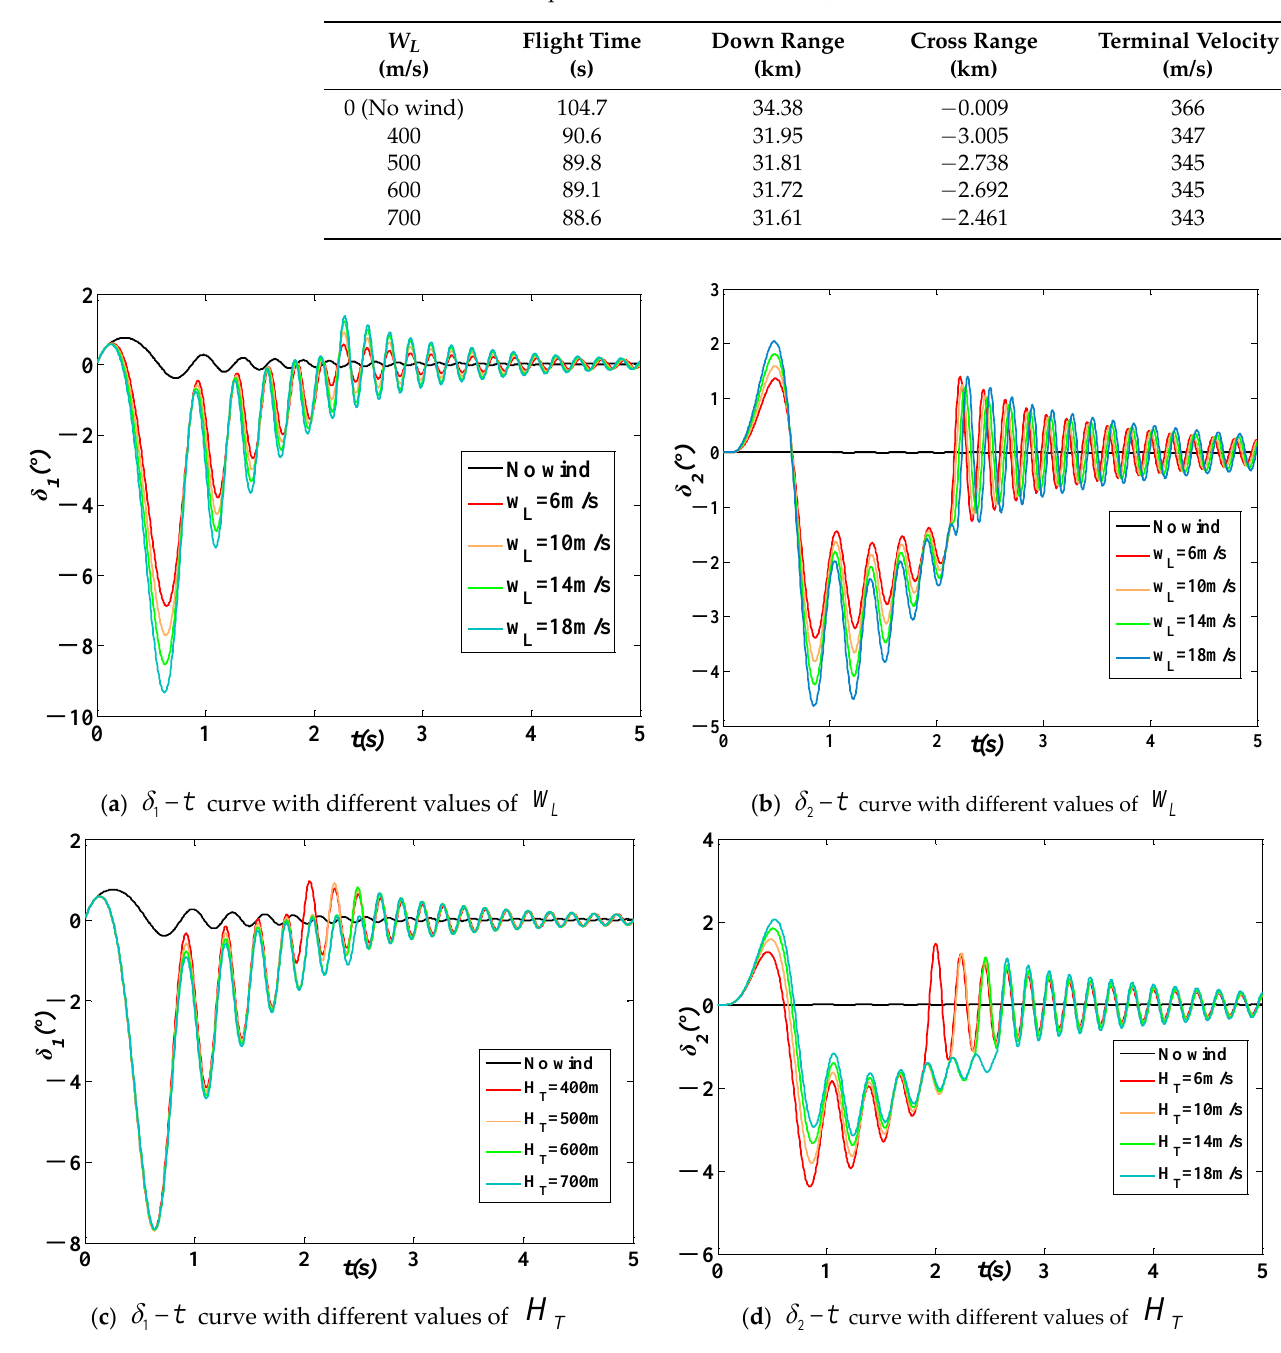
curve with different values of Figure 15. Attack angle curves with different wind field model